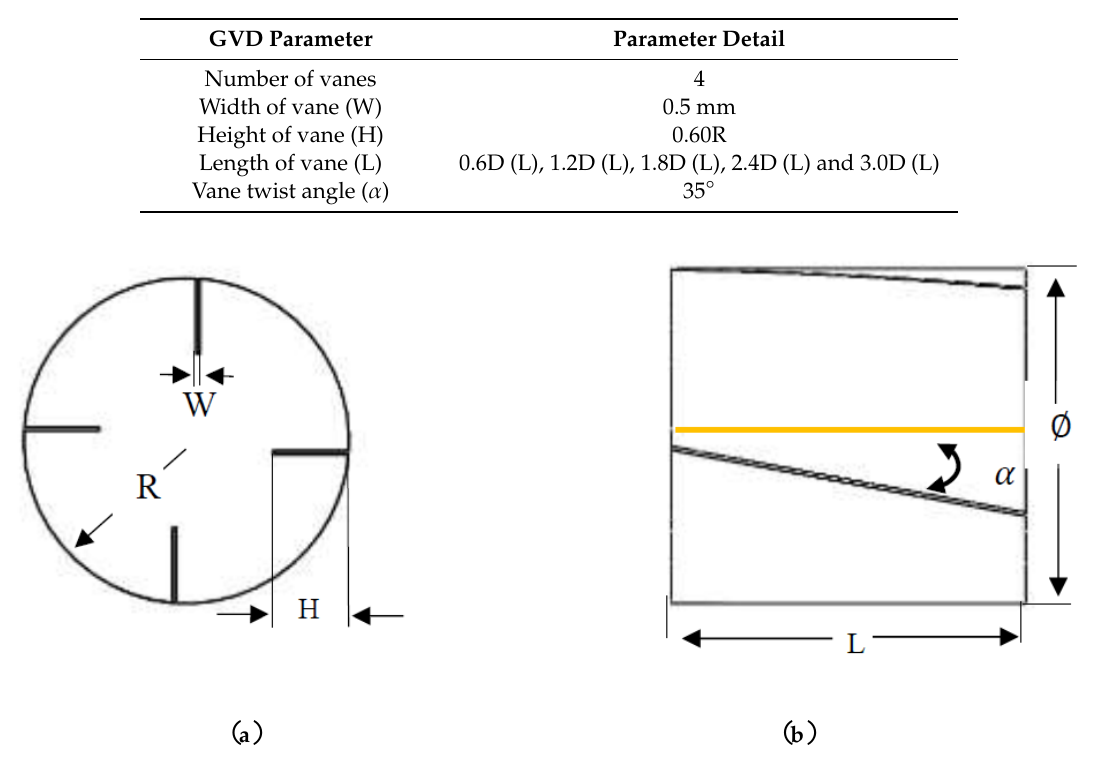
Table 2. Specification parameters of the GVD.